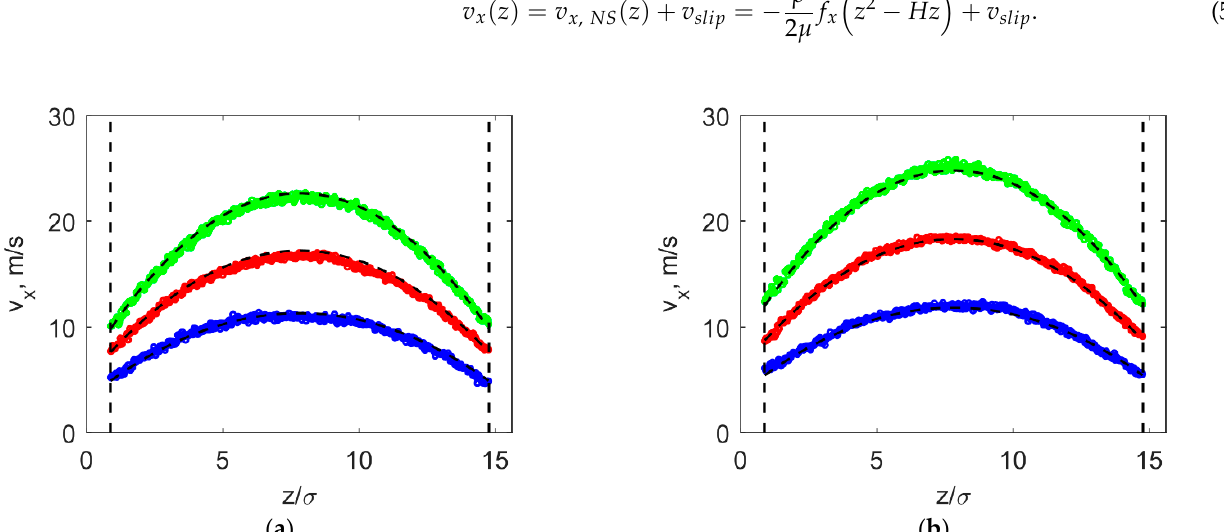
Figure 5. Water velocity profiles along the z -axis in ( a ) FW simulations and ( b ) DW simulations with varying values flow inducing force f x . The blue, red, and green markers represent simulation results with flow-inducing force values of 1.77 × 10 12 , 2.65 × 10 12 , and 3.53 × 10 12 N/kg, respectively. Parabolic dotted lines represent NS solution (Equation (4)), while vertical dotted lines indicate σ CuO distances from the atomistic planes of the walls, which are in contact with